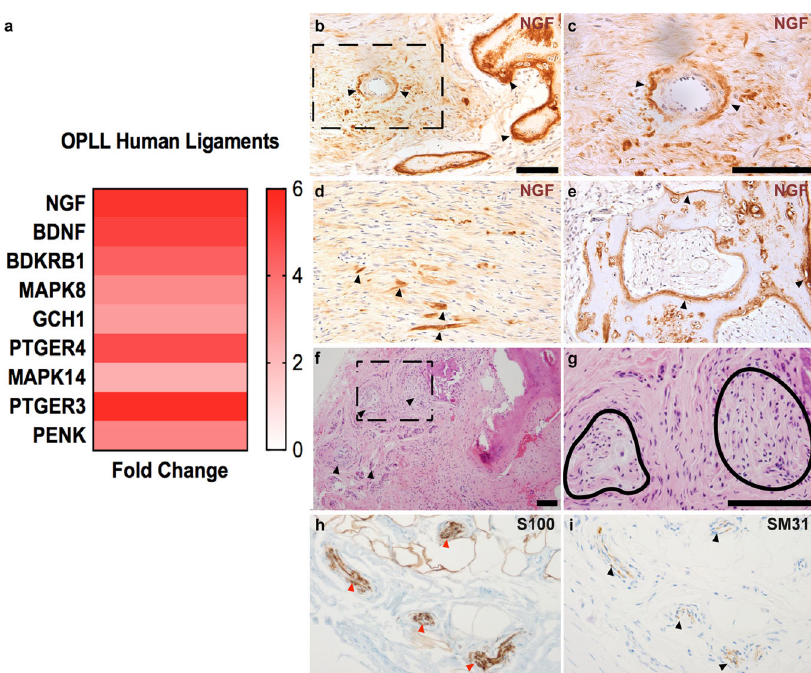
Fig. 9 NGF-TrkA signaling and innervation within human heterotopic ossi fi cation (HO). a NGF signaling among ligamentous cells derived from patients with ossi fi cation of the posterior longitudinal ligament (OPLL) [GEO microarray data (GSE5464)]. NGF expression was increased within the OPLL group relative to the control group (log fold change 5.48, p = 0.02). b – e NGF immunohistochemical staining within clinical examples of ( b , c ) perivascular cell- associated NGF at low and high magni fi cation. Dashed black box shows the high magni fi cation images in panel ( c ). d , e Immunostaining of NGF in early- and late-stage human HO, respectively. NGF immunostaining appears brown, while hematoxylin counterstain appears blue. Arrowheads indicate NGF immunostaining. f – i Axonal invasion within clinical examples of late-stage human HO. f , g Representative HO sites at low and high magni fi cation, respectively. Arrowheads and black lines indicate HO-associated nerve fi bers. h , i Immunohistochemical staining to highlight nerve fi bers in human HO, including ( h ) S100 (red arrowheads) and ( i ) SM31 (black arrowheads). Scale bars: 100 μ m. Statistical analysis was performed using a two-way Student ’ s t test. N = 12 Human samples. See Supplementary Table S4 for a description of locations and demographics of human